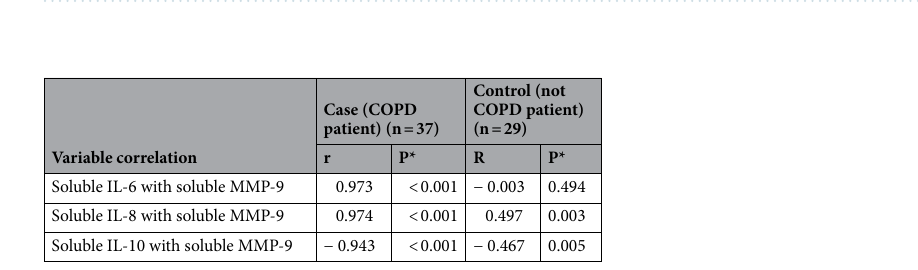
Table 7. Correlation of soluble cytokine levels (IL-6, IL-8 and IL-10) with MMP-9. *Spearman correlation.